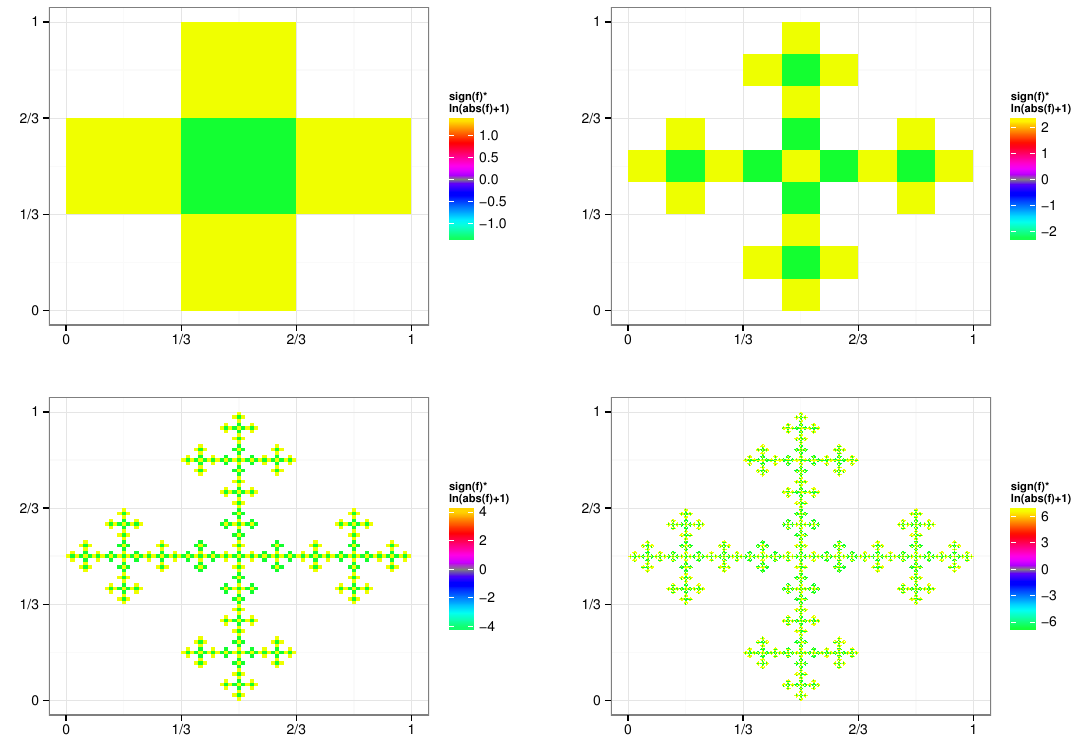
( Π ) , with τ 1 according to Example 2.1 and n ∈ { 1, 2, 4, 6 Figure 1: Density f of W n τ 1